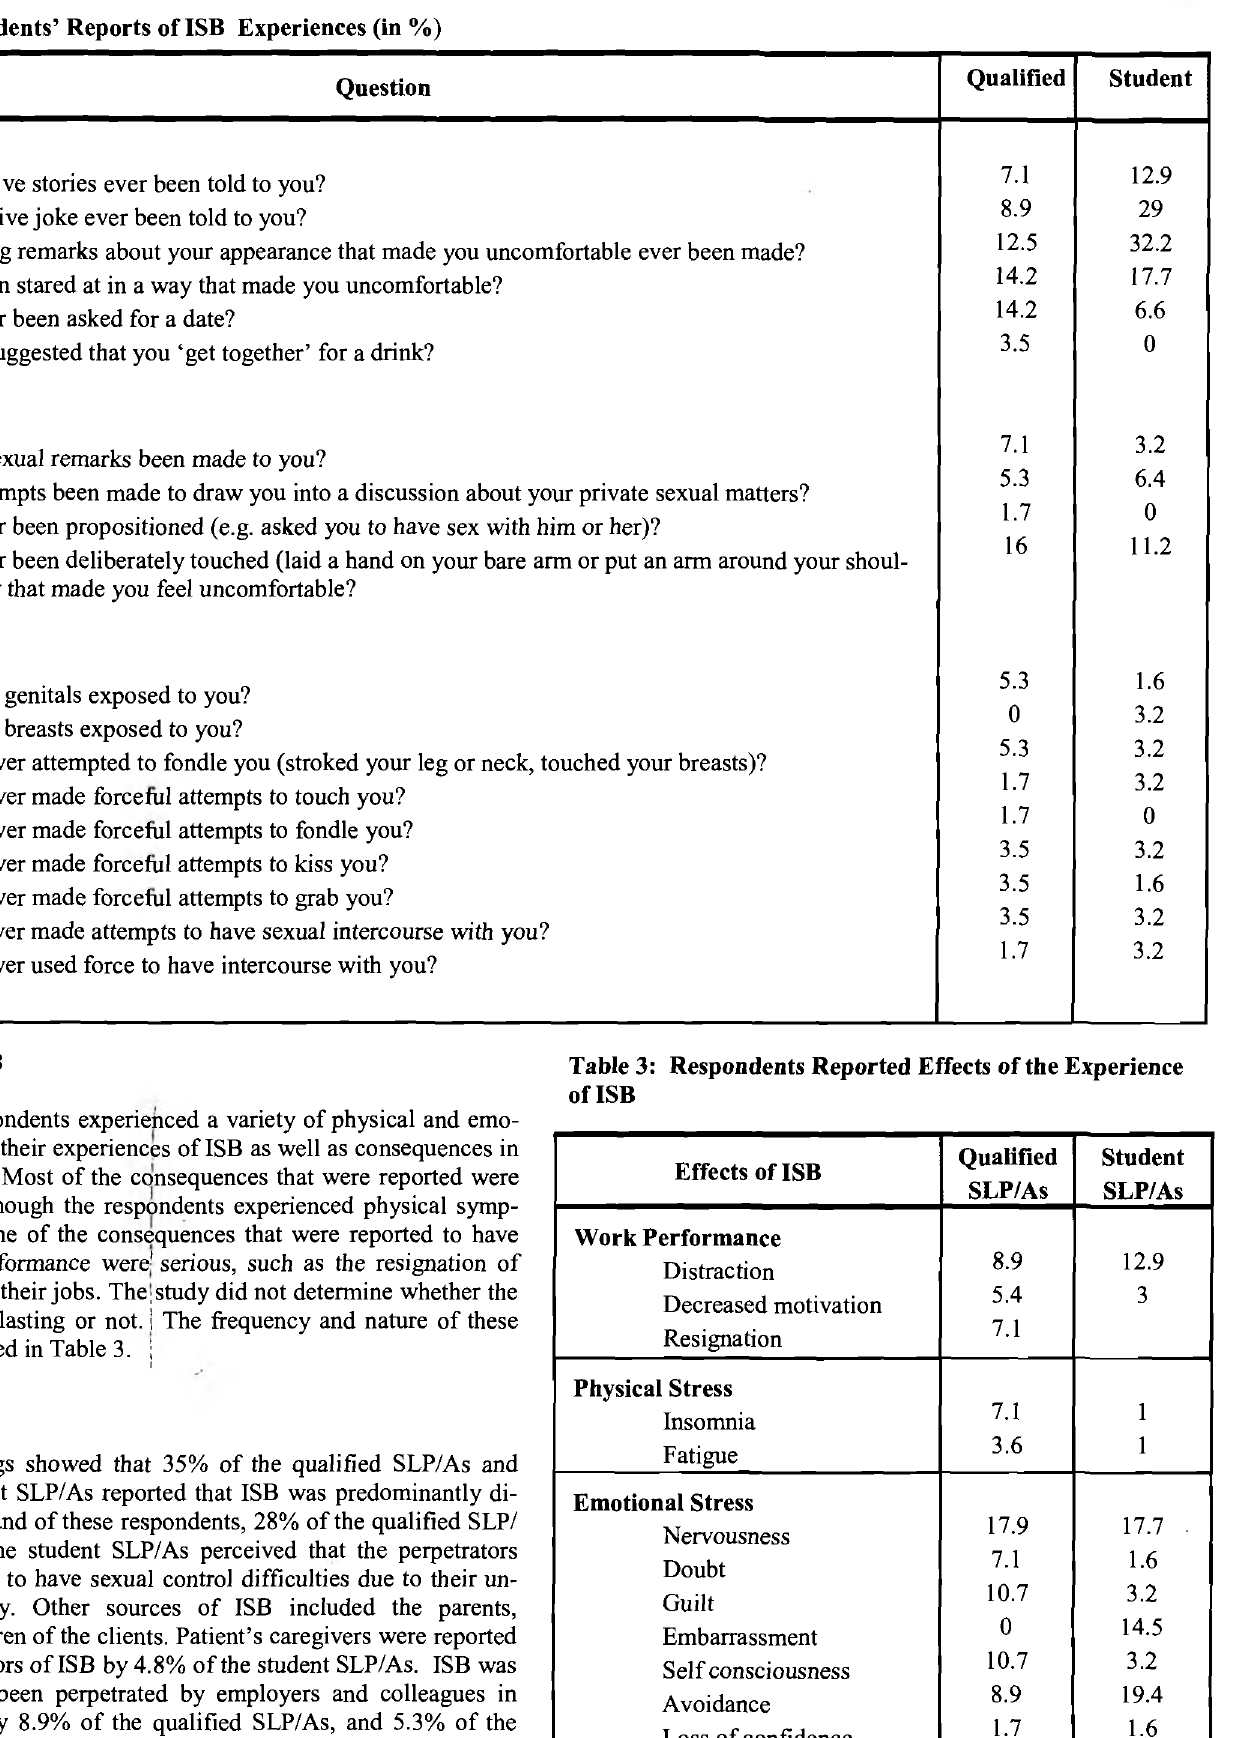
Table 2: Respondents’ Reports of ISB Experiences (in %)